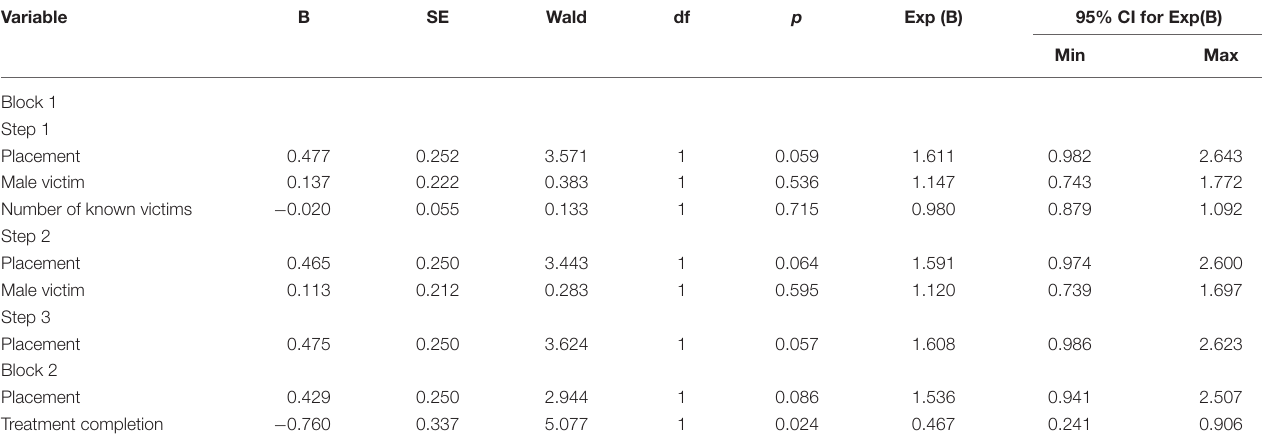
TABLE 3 | Final cox regression predicting violent recidivism (including sexually).